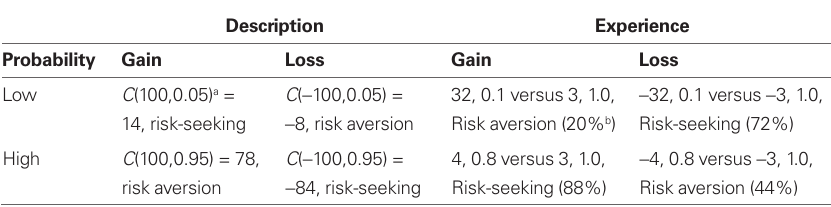
Table 1 | Fourfold pattern in decisions from description and reversed pattern in decisions from experience (Hertwig,